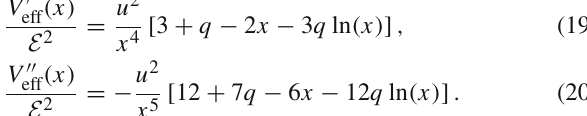
q means the cosmic censorship hypothesis [61] is respected for hairy black hole in Horndeski